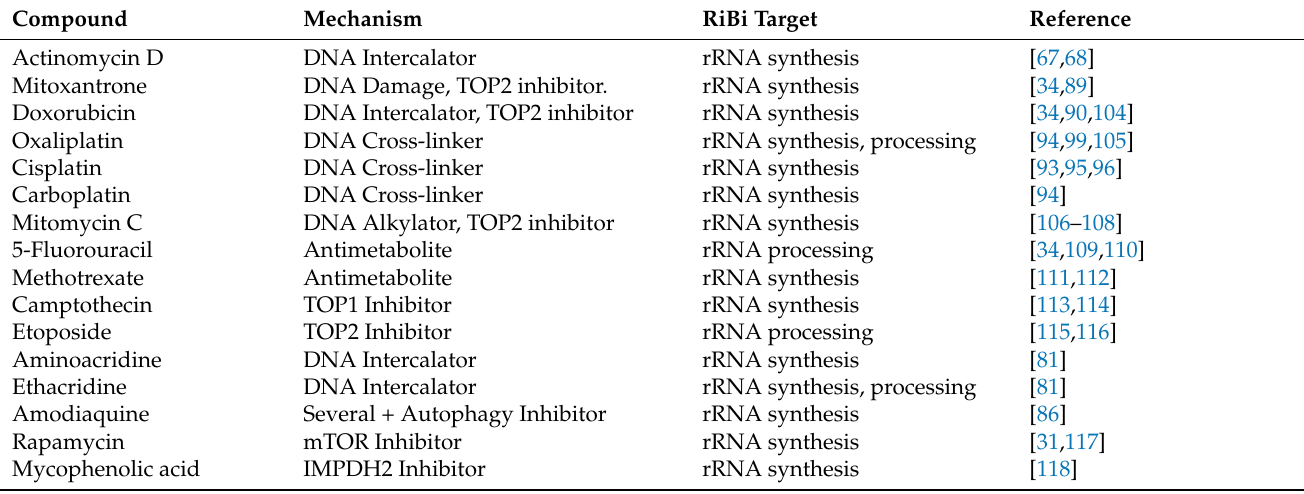
Table 1. Examples of drugs approved for clinical use that impair ribosome